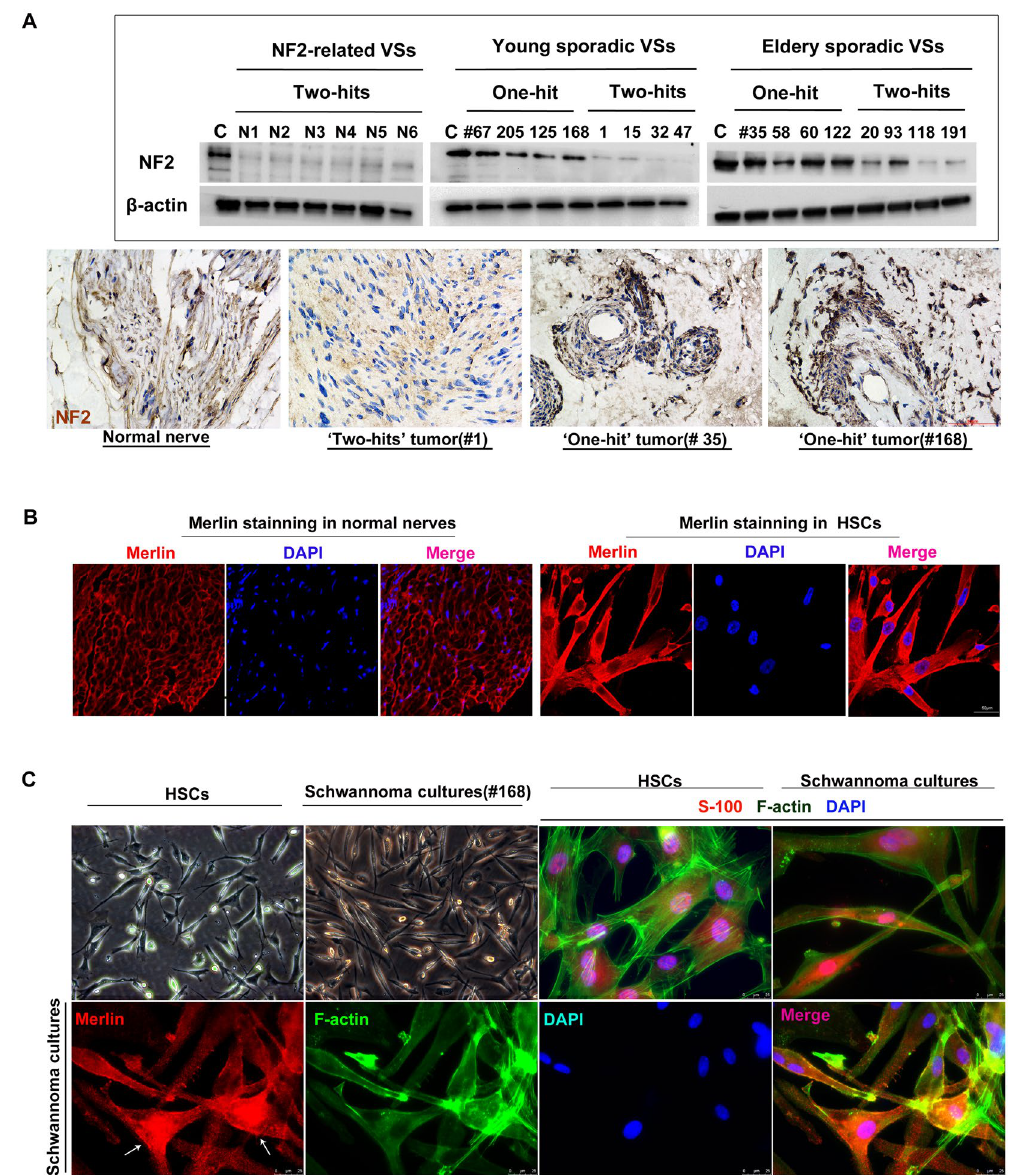
Figure 3. The expression and subcellular localization of merlin protein in sporadic VSs with different NF2 gene statuses. (A) The Immunoblot analysis revealed strong merlin levels in the normal vestibular nerve (C, Control). None or very faint 70-kDa merlin-specific bands were demonstrated in six NF2-related schwannomas (N1 to 6) and in eight ‘two-hits’ tumours except for #93. Almost all five ‘one-hit’ tumours were found to exhibit distinct intensity of the 70-kDa band (Upper). A loss of merlin expression ( < 5% immunostaining) was detected in ‘two-hits’ tumours, while nuclear staining of merlin was observed in ‘one-hit’ tumours (Below). (B) The merlin staining of a normal vestibular nerve (left) and HSCs (Right). (C) The staining of Schwann cell marker S100 and F-actin in HSCs (Upper left) and schwannoma primary cultures (Upper right). In contrast to the staining homogeneity in HSCs (Upper left), a significant proportion of schwannoma cultures demonstrated strong merlin staining (white arrowheads, Lower panel) and others showed faint staining. Full-length gels are presented in Supplementary Figure